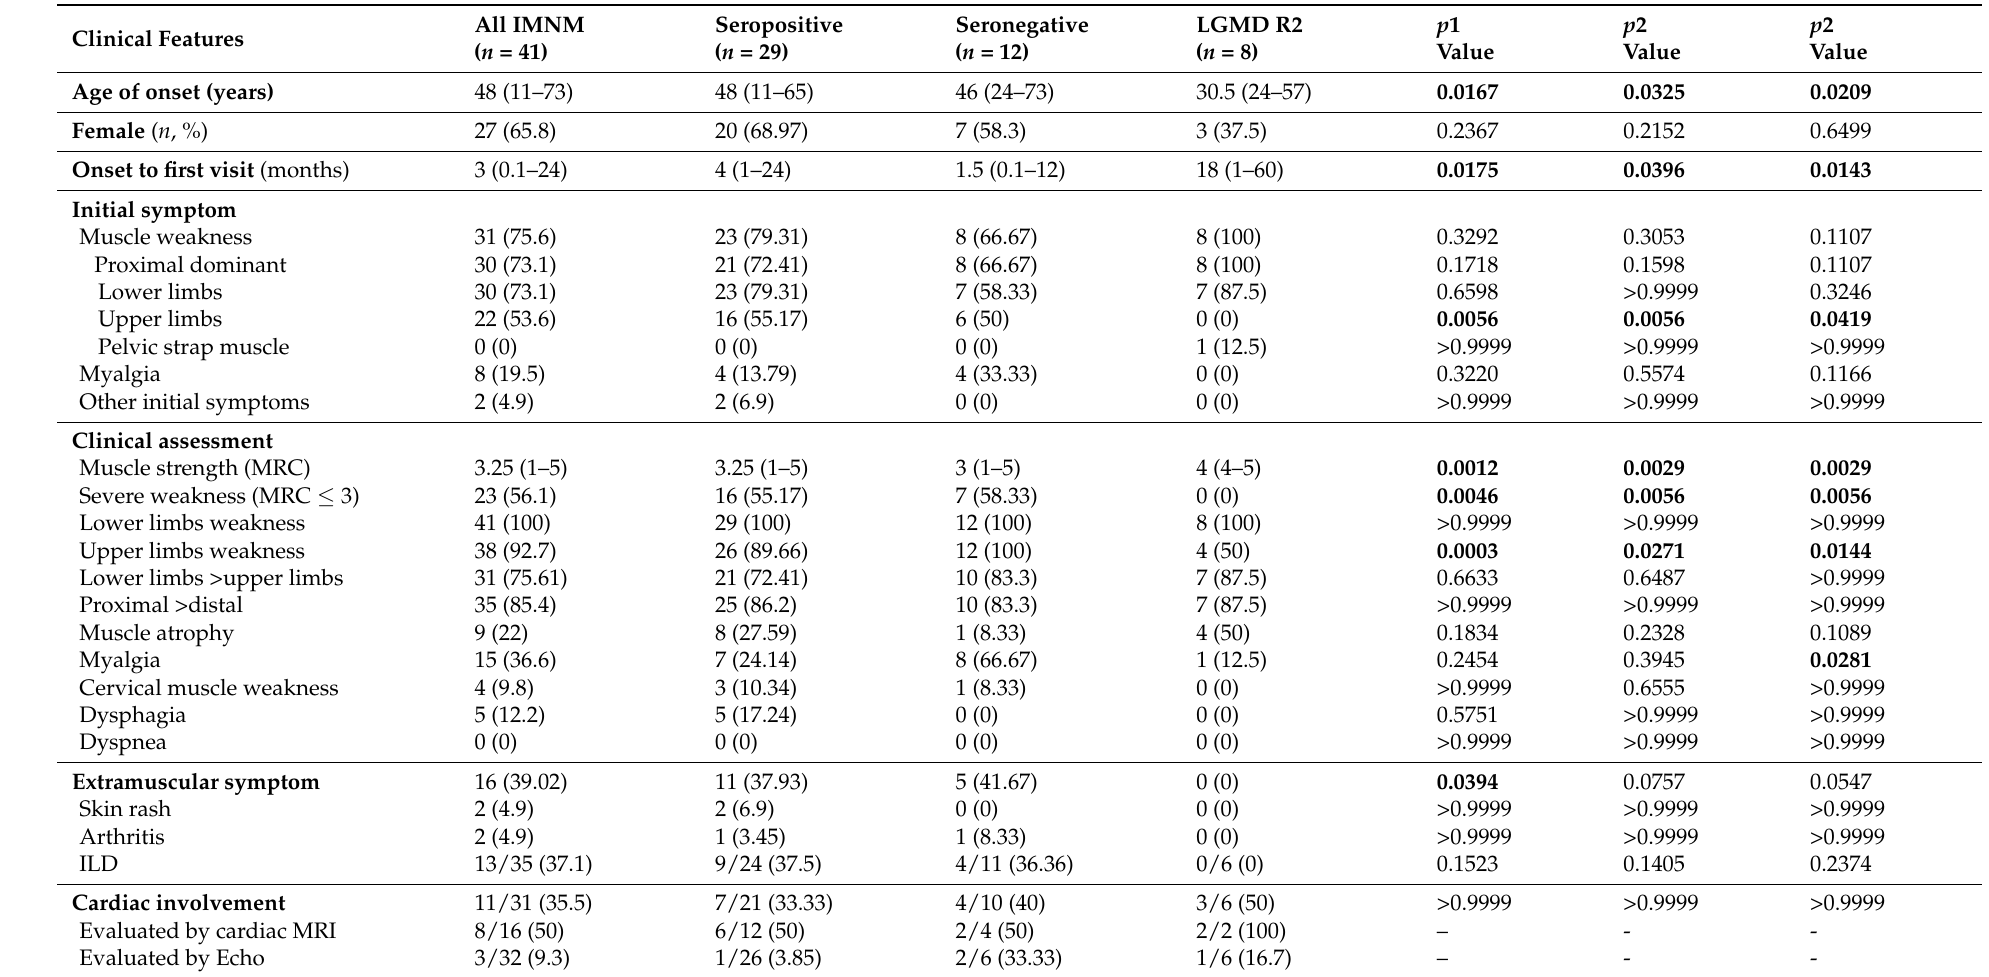
Table 1. Comparison of the clinical features between IMNM and LGMD